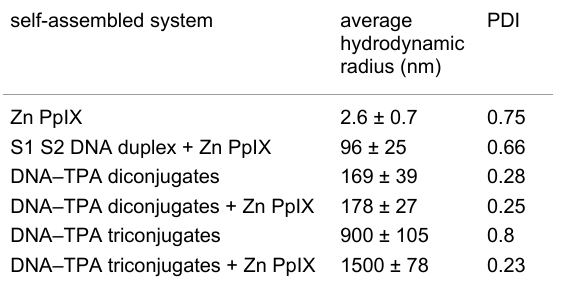
Table 2: Hydrodynamic size (nm) and PDI values for different systems obtained from number distribution analysis of DLS data. Zn PpIX was added during